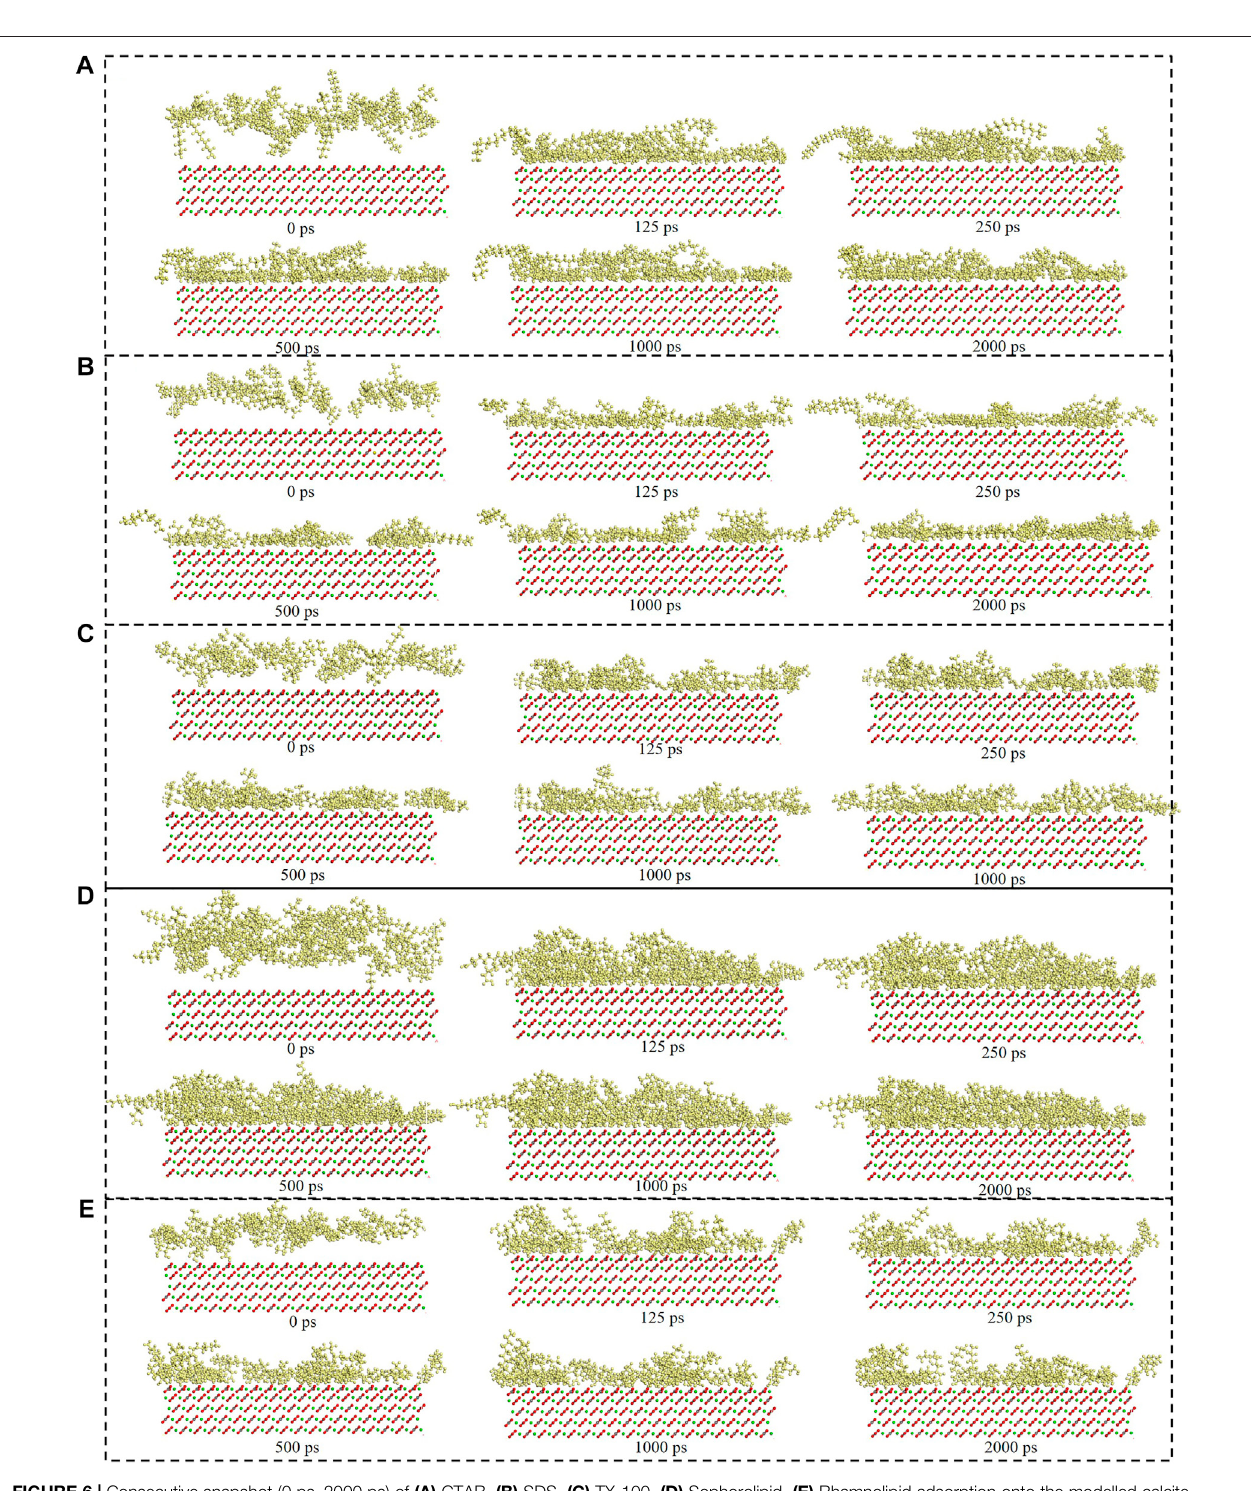
FIGURE 6 | Consecutive snapshot (0 ps – 2000 ps) of (A) CTAB, (B) SDS, (C) TX-100, (D) Sophorolipid, (E) Rhamnolipid adsorption onto the modelled calcite surface. yellow = surfactants, red and grey = CO 3 2- , green = Ca 2+ , red, grey and green = calcite surface.